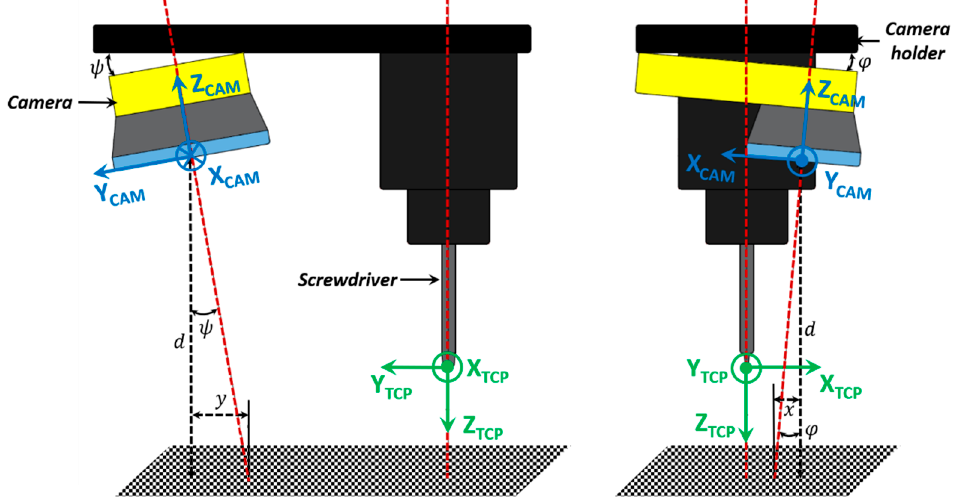
Figure 8. Mounting errors of the camera positioned on the UR10 tool flange with respect to the Tool Center Point.